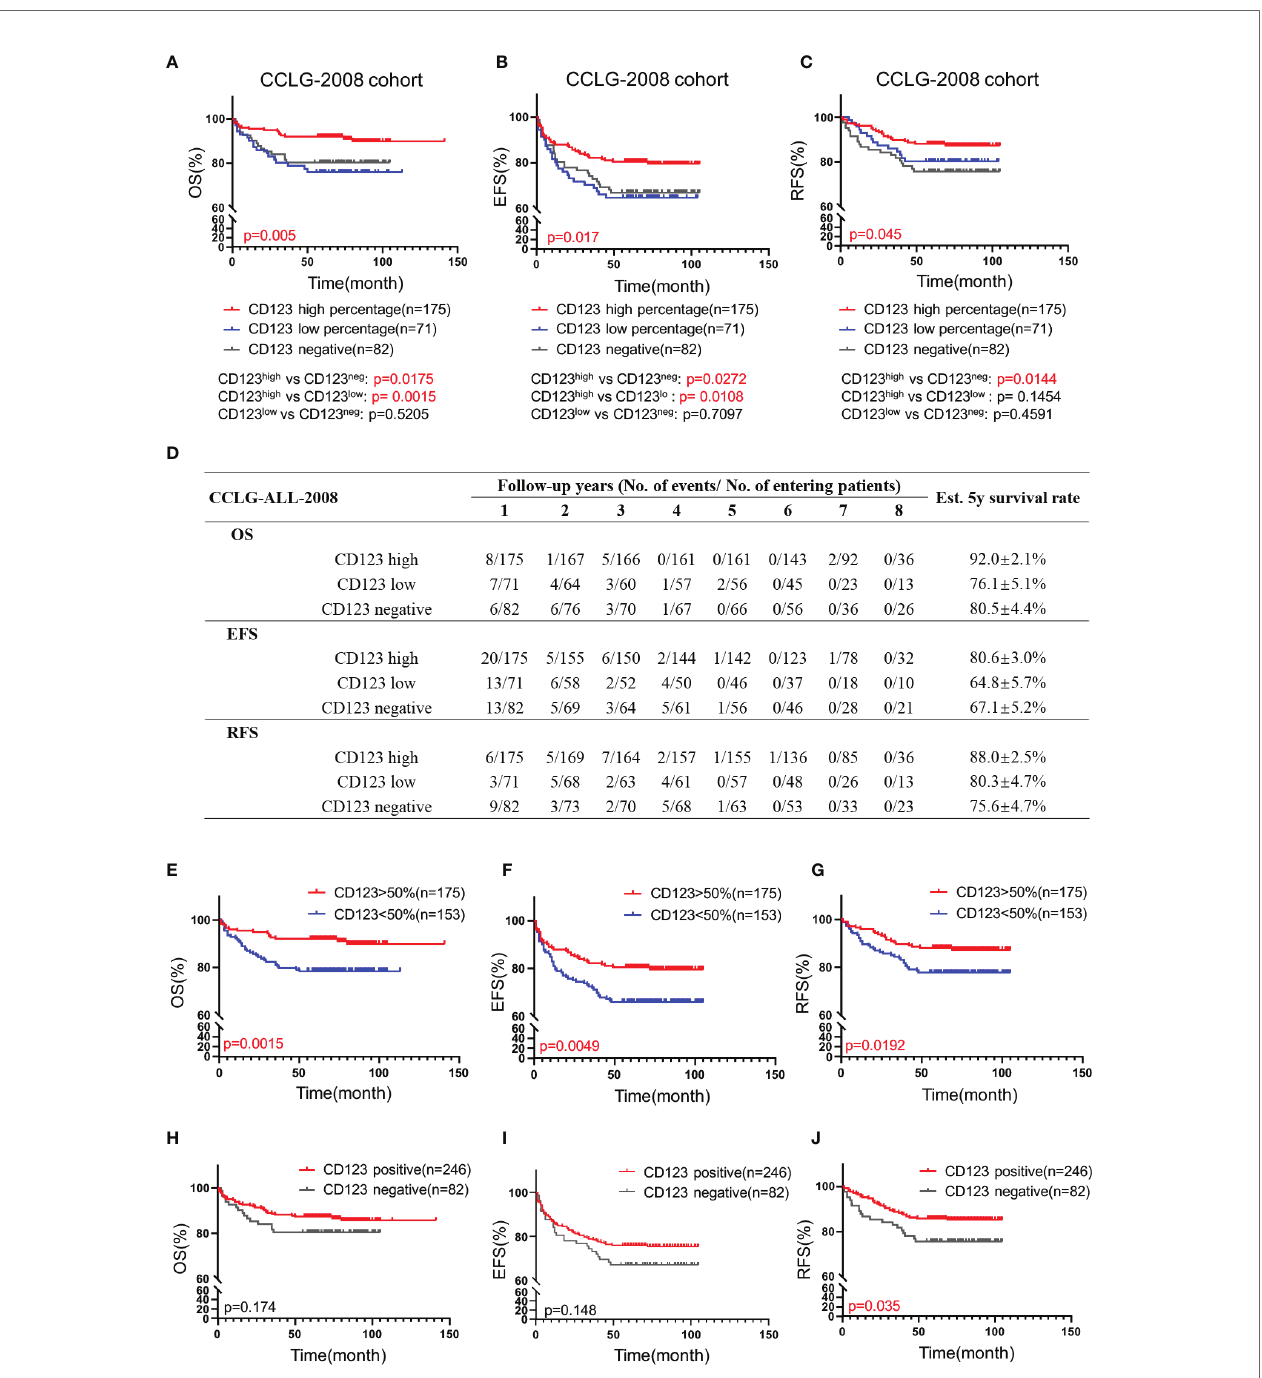
FIGURE 2 | High CD123 expression correlates with favorable clinical outcomes of pediatric B-ALL treated with CCLG-ALL-2008 protocol. Comparison of OS (A) , EFS (B) , and RFS (C) among CD123 high , CD123 low , and CD123 neg groups in the CCLG-ALL-2008 cohort; (D) The detailed number of event occurrences and cases under observation in the CD123 high , CD123 low , and CD123 neg groups in every follow-up year. Estimated 5-year survival rates in each group were calculated; Comparison of OS (E) , EFS (F) , and RFS (G) between patients with over or less than 50% blasts expressing CD123; Comparison of OS (H) , EFS (I) , and RFS (J) between patients positively or negatively expressing